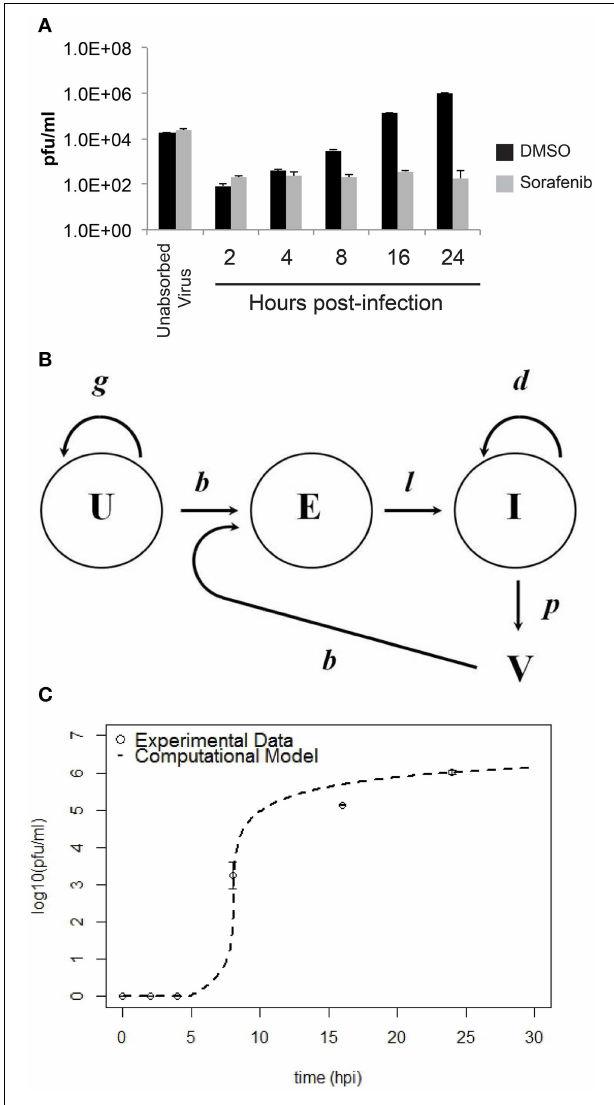
FIGURE 6 | Comparison between experimental data and the computational model for HSAEC infection. (A) Virus in the culture supernatant (2–24 hpi) after the addition of sorafenib (gray bars) or DMSO-vehicle (black bars). Data are average pfu/ml ± standard deviations and each bar represents three biological replicates. (B) Schematic of the computational model showing uninfected HSAECs (U), early infected HSAECs (E), infected virus-producing HSAECs (I) and Virus particles (V) (see text for additional details). (C) Comparison between experimental data and model results. Open circles are the DMSO-vehicle data reproduced from (A) and the dashed line is pfu/ml data produced from the computational model using the parameter values summarized in Table 1 .